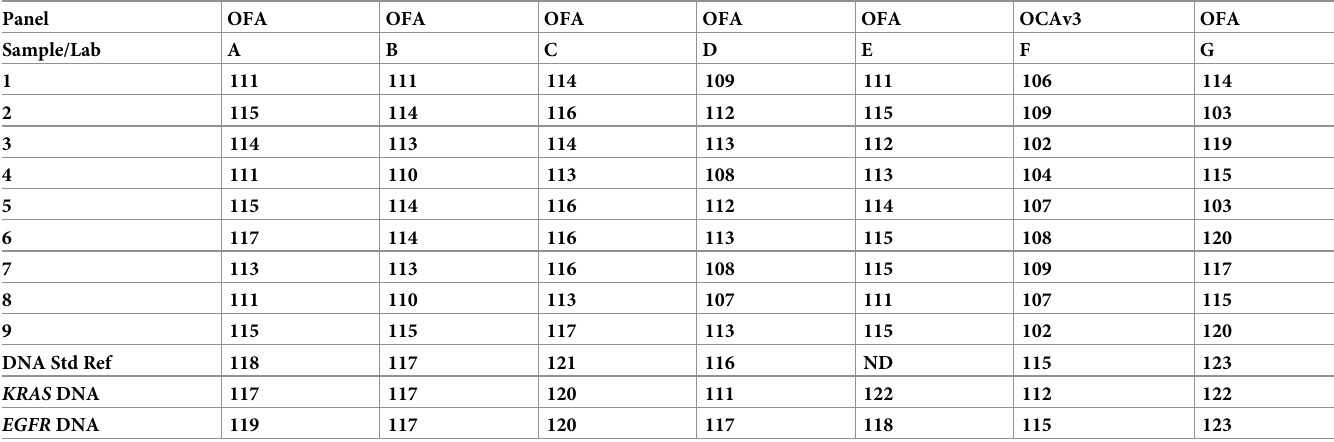
Table 2. Phase 1 DNA read length